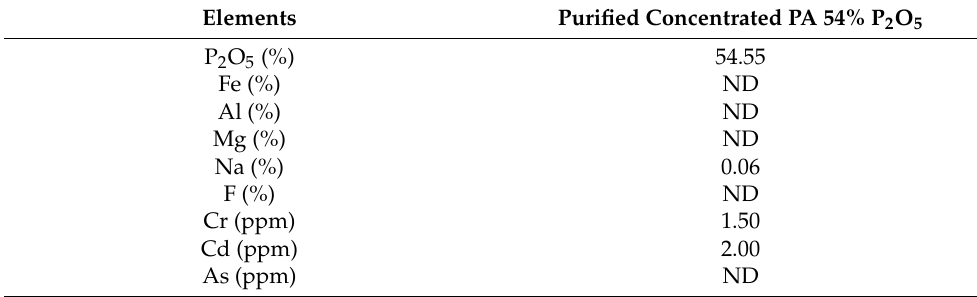
Table 3. Purified concentrated phosphoric acid composition.